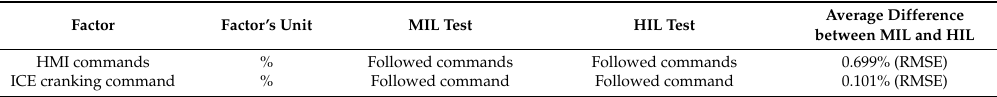
Table 5. Summary of correlation between MIL and HIL results during cycle 7th.